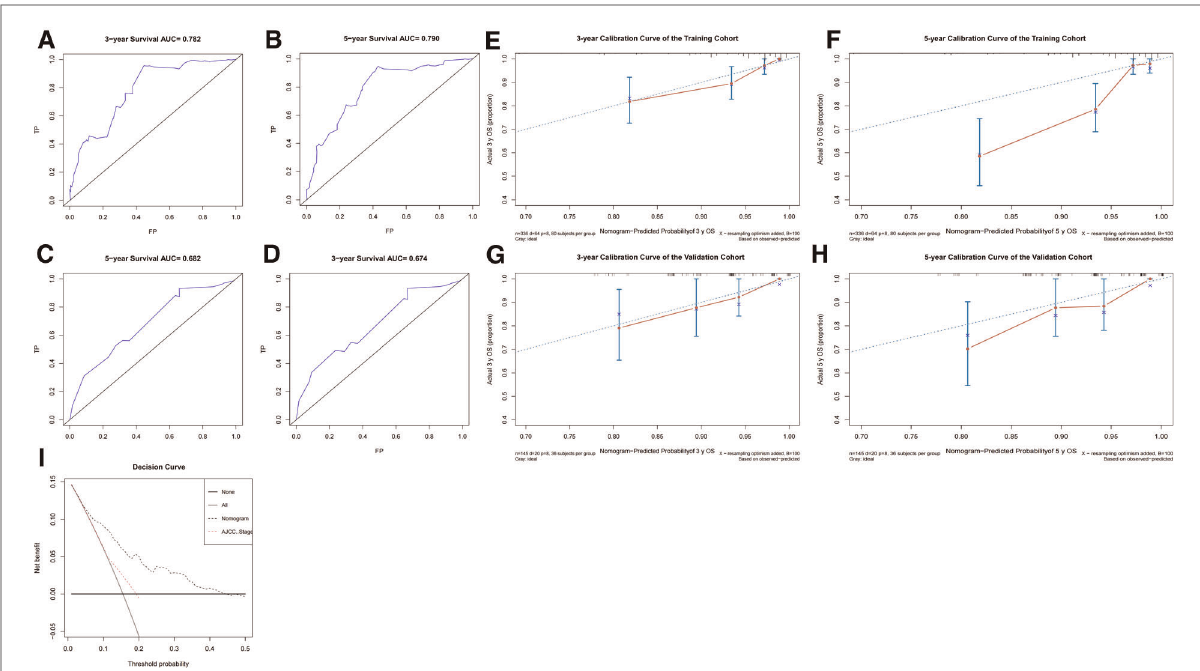
FIGURE 5 The predictive performance evaluation of this nomogram. ( A – D ) The ROC curves of the training cohort ( A,B ) and the validation cohort ( C,D ); ( E – H ) the calibration curves of the training cohort ( E,F ) and the validation cohort ( G,H ); ( I ) The DCA curves for nomogram and AJCC TNM staging of the total cohort. AJCC, American Joint Committee on Cancer; DCA, decision curve analysis; ROC, receiver operator characteristic.